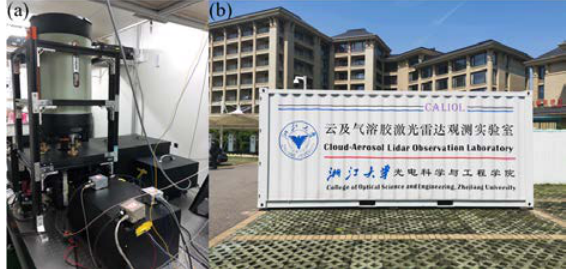
Fig.1. (a) The dual-wavelength high spectral resolution lidar, (b) the experimental container deployed in Zhoushan to accomplish the first field